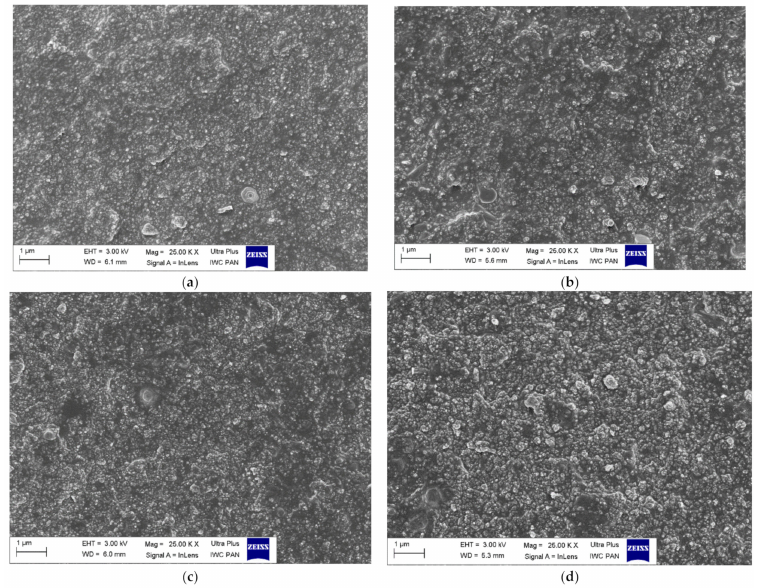
Figure 4. Scanning electron microscopy (SEM) images of SBR vulcanizates: ( a ) A380; ( b ) VN3; ( c ) A380/BmiBr; ( d )